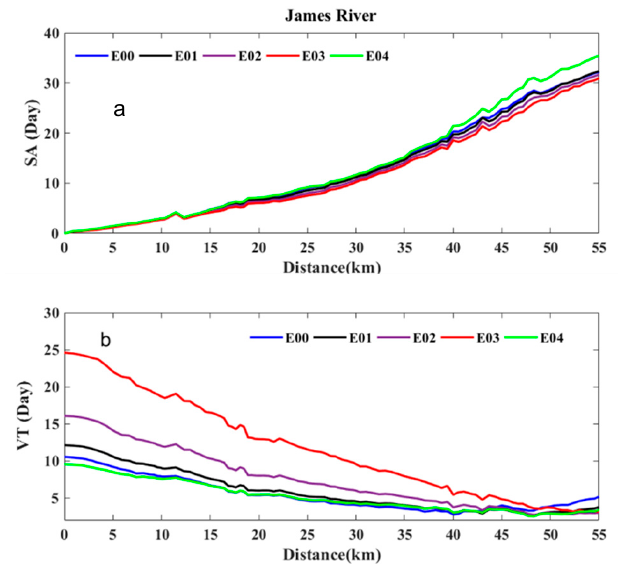
Figure 5. Variation of the annually averaged saltwater age and the vertical exchange time along the channel with respect to channel deepening and the sea-level rise. ( a ) Saltwater age; ( b ) Vertical exchange time.